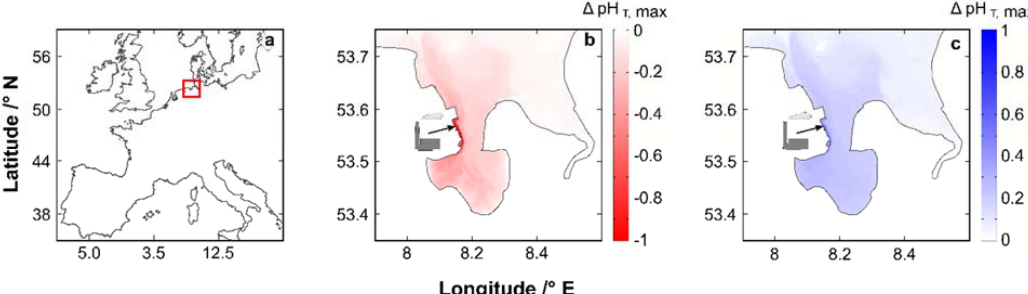
Figure 1. Impacts of AWL-derived water on the pH T of a coastal ecosystem. The application of AWL at a coal-fired power plant, and the superficial discharge of the resulting water, were simulated over a period of four months. Maximum observed changes to the undisturbed system are shown. The area in the red rectangle in ( a ) is enlarged in ( b , c ), respectively. ( b ) Water is discharged directly after it leaves the AWL reactor (pCO 2 within the reactor ~120,000 ppmv; pH T = 6.8). ( c ) Water has been degassed to equilibrium of CO 2 with the atmosphere before it is discharged (pH T = 8.6). The arrow indicates the discharge site close to an existing power plant. The color bars have been capped for better visualization.